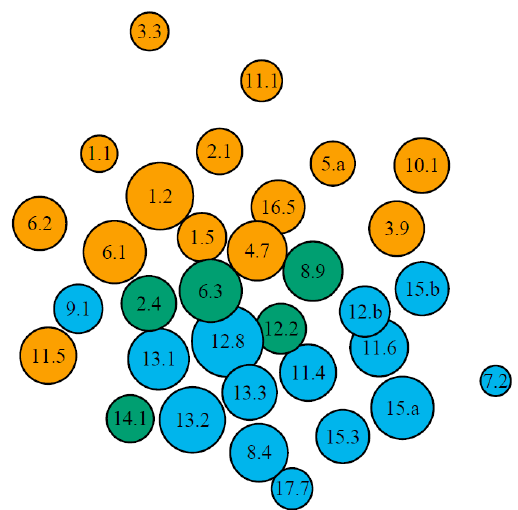
Figure 6. Unimodal networks of all reinforcing (+2) and enhancing (+1) interactions among selected Sustainable Development Goals (SDG) targets clustered into three communities that represent the different groups depending on their interactions. The size of the nodes represents the number of connections each target has to other targets. Interactions are not shown for visualizations purposes.